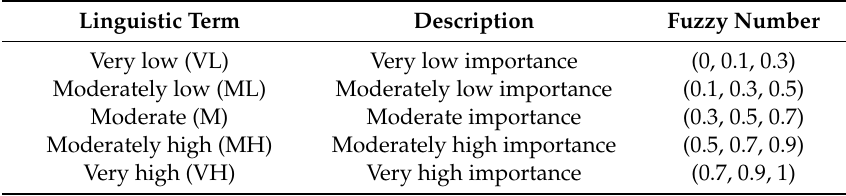
Table 4. Fuzzy evaluation criteria of risk factor